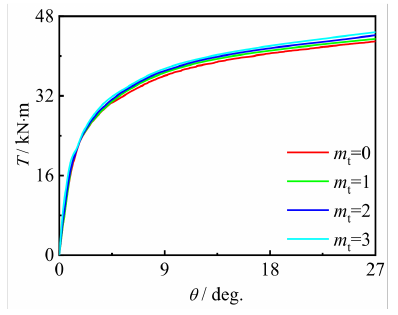
Figure 21. Effect of m t on T - θ